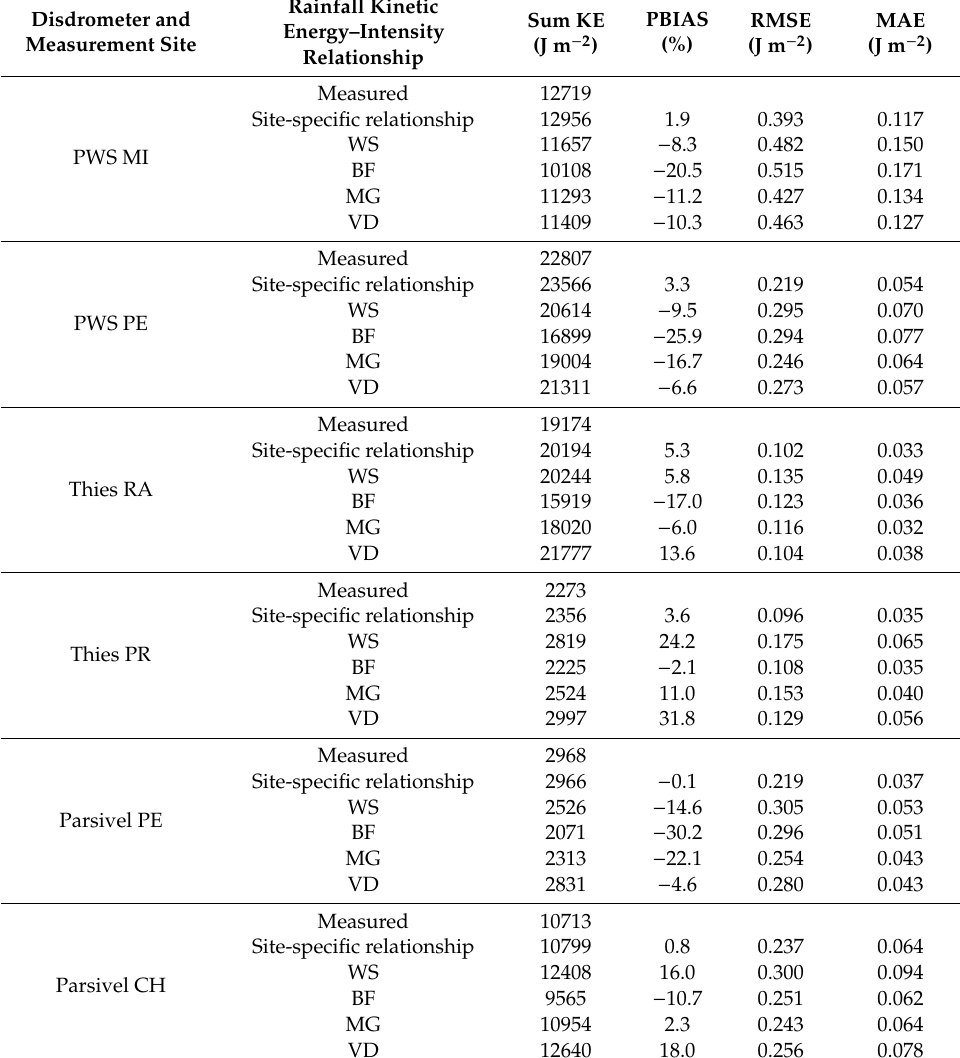
Table 5. Comparison of the measured rainfall kinetic energy to that found from the calibration of the site- and device-specific rainfall kinetic energy–intensity relationships and the rainfall kinetic energy–intensity relationships Wischmeier and Smith (WS); Brown and Foster (BF); McGregor et al. (MG); and van Dijk et al. (VD) from the